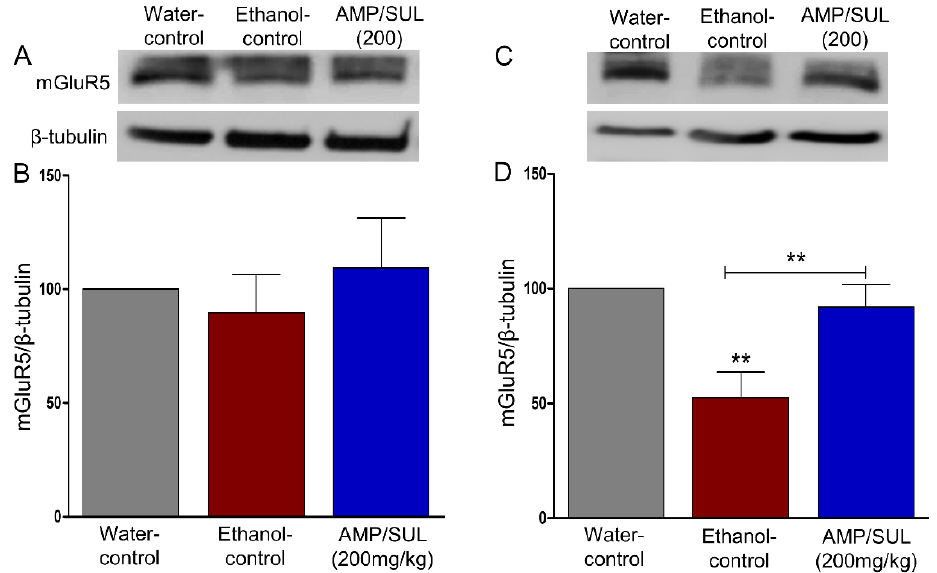
Figure 6. Effects of AMP/SUL treatments (200 mg/kg, i.p.) for five days on the expression of mGluR5 in the AcbCo and AcbSh. ( A ) Immunoblot of mGluR5 and β -tubulin in the AcbCo. ( B ) Quantitative analysis using one-way ANOVA followed by Newman-Keuls test indicated that there were no significant differences in the expression of mGluR5 among water-control, ethanol-control, and ethanol-AMP/SUL (200 mg/kg) groups in the AcbCo. ( C ) Immunoblot of mGluR5 and β -tubulin in the AcbSh. ( D ) Quantitative analysis using one-way ANOVA followed by Newman-Keuls test indicated that there was a significant decrease in the mGluR5 expression in the ethanol-control group compared to the water-control group, while post-treatment with AMP/SUL (200 mg/kg) for five days increased mGluR5 expression in the AcbSh. The symbol of statistical significance between any group and water-control group is shown on the bar of the group. Water-control group data were represented as 100% (relative to water-control). The values are expressed as mean ± SEM ( n = 5/group), (** p < 0.01).